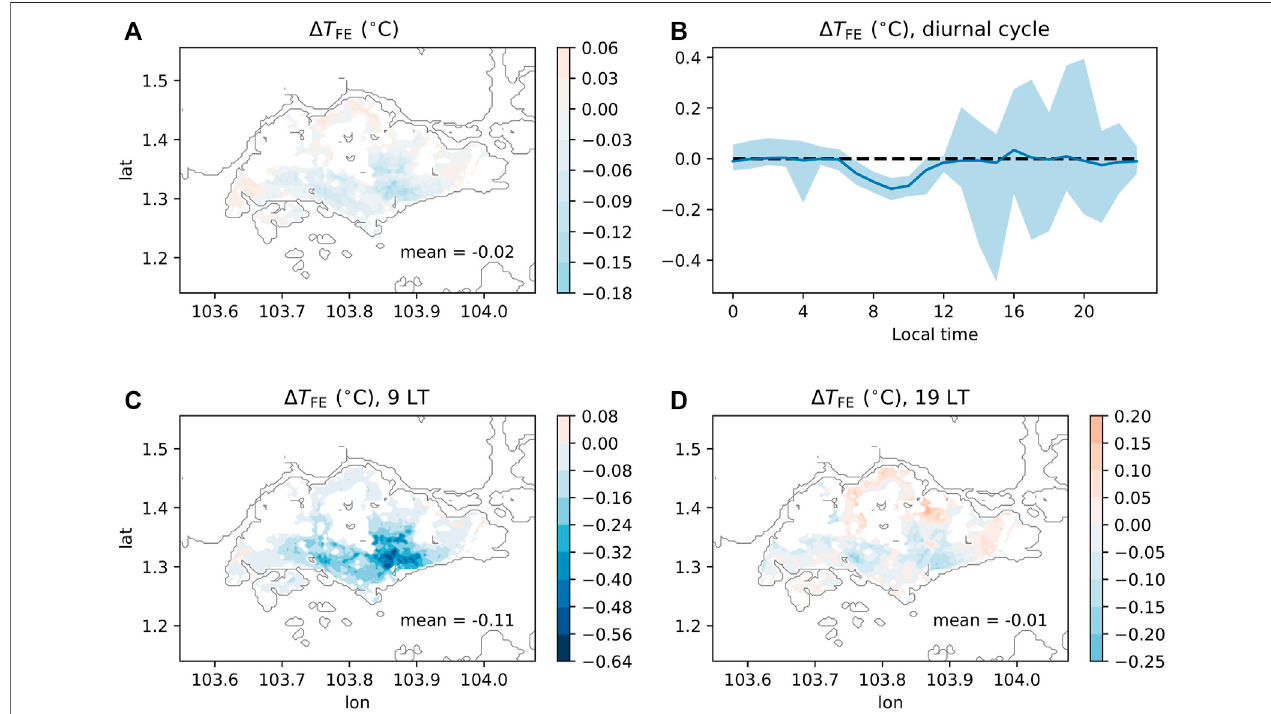
FIGURE 2 | Full electri fi cation of the fl eet (FE) mitigates heat, mostly after the morning traf fi c peak in the central urban area. (A) shows the period-average near- surface air temperature difference ( Δ T FE , ° C) between FE and REF, (B) shows the period-average diurnal cycle of Δ T FE , (C) shows the period-average T FE at 9 local time (LT) and (D) shows the period-average Δ T FE at 19 LT. Only values over the urban area (de fi ned as f urb > 0.1) are shown.